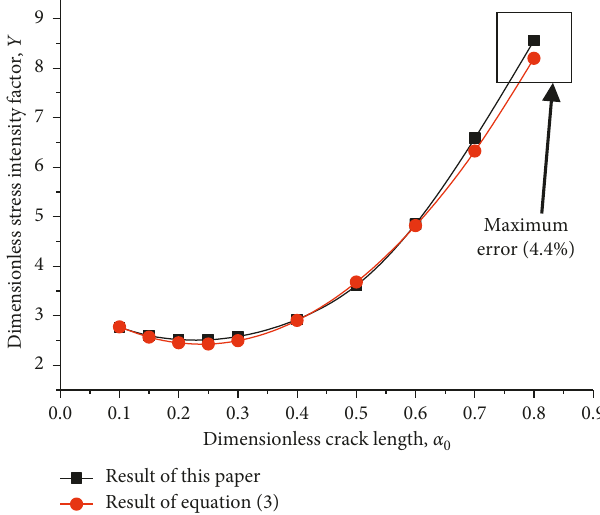
Figure 2: Comparison between calibration result of this paper and that obtained by formula